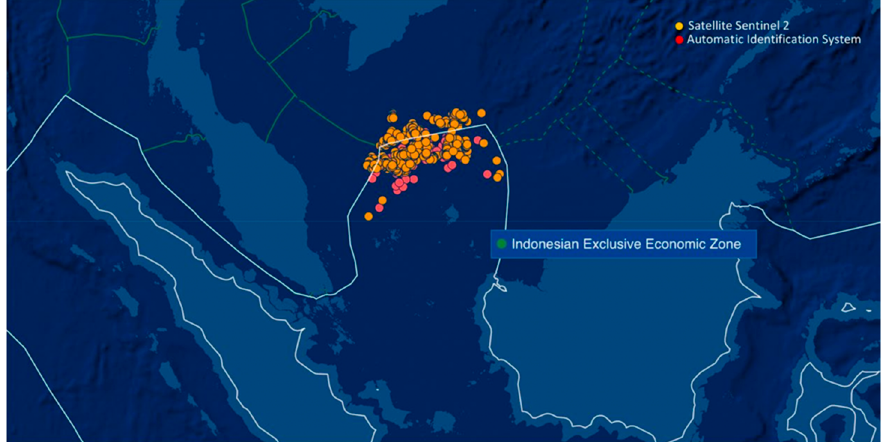
Figure 2. Areas of Vietnamese IUUF in the Natuna Waters in 2021 (based on satellite Sentinel-2 and an automatic identification system). Source: Indonesia Ocean Justice Initiative (IOJI 2022d).